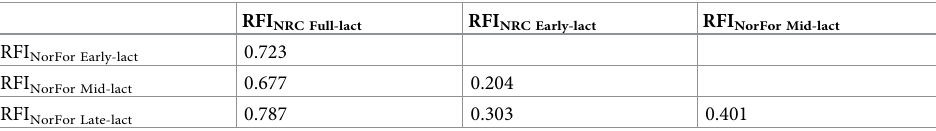
Table 7. Pearson correlation matrix for residual feed intake calculated using the NRC (2001) equation (RFI NRC ), estimated using data collected at different stages of the lactation and for the full lactation (n =